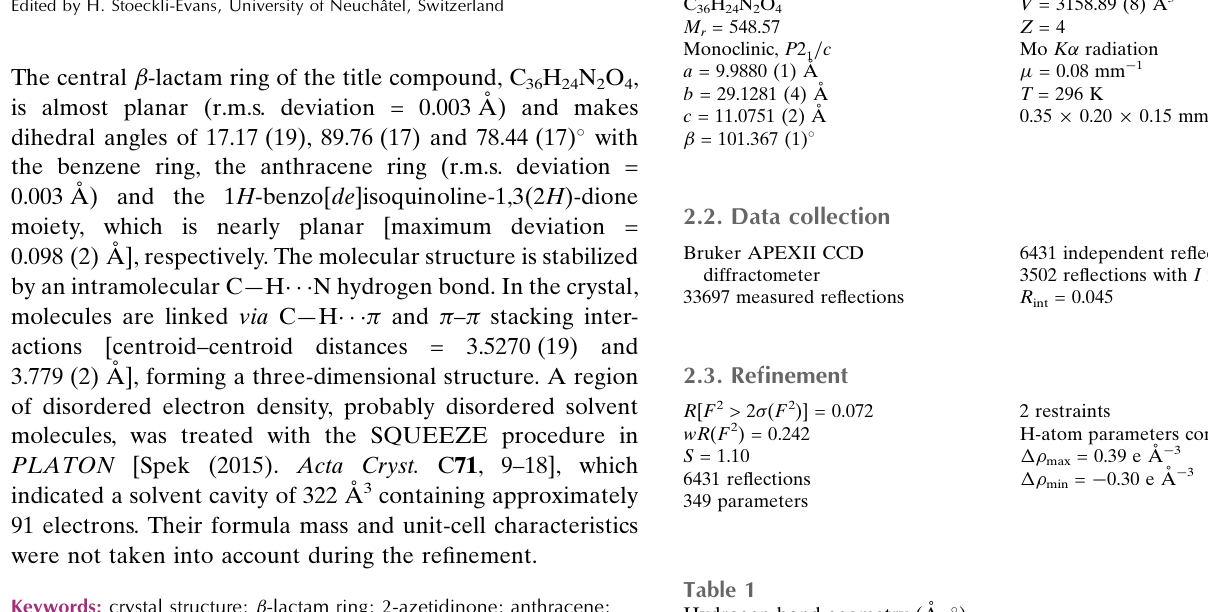
Hydrogen-bond geometry (A˚ , (cid:2)